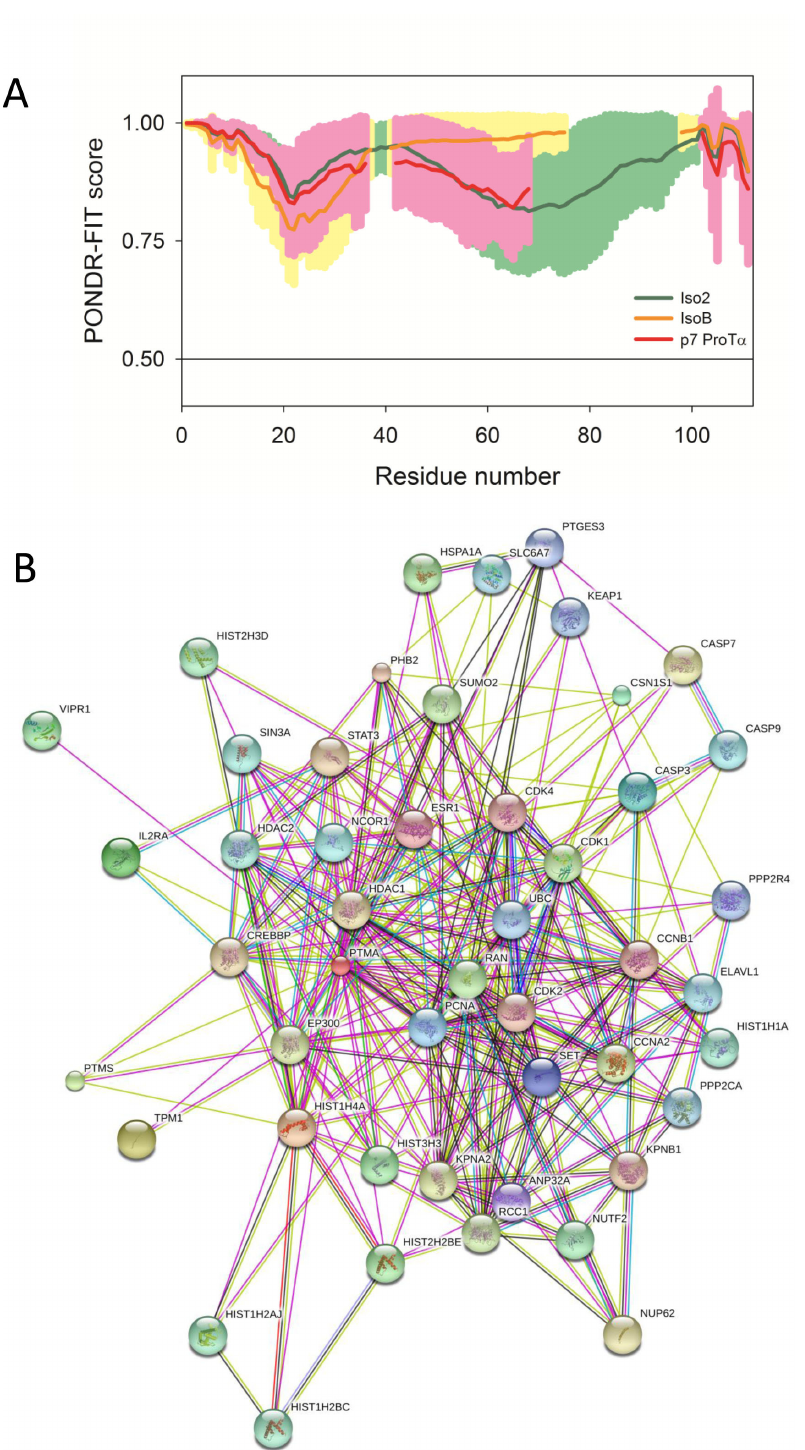
Fig 5. ProT α variants are predicted to be intrinsically disordered proteins with high binding promiscuity. ( A ) Per-residue disorder distribution in variants of human ProT α (green line and shade – iso2; yellow line and shade – isoB variant; red line and shade – p7 ProT α variant). Disorder propensity was evaluated by PONDR-FIT. Scores above 0.5 correspond to disordered residues/regions. Profiles were aligned to match some specific disorder-based feature. Shades represent distribution of errors in disorder estimation